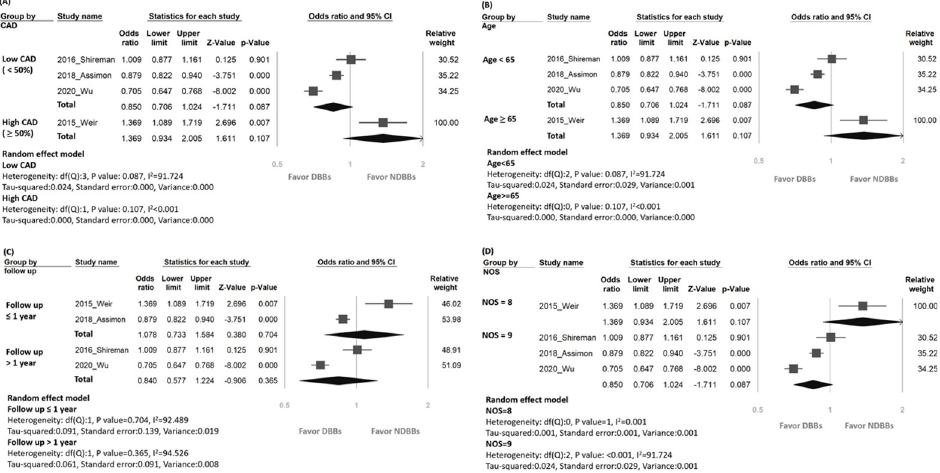
Fig 3. Forest plots of subgroup analysis of the effects of (A) low ( < 50%) vs. high ( � 50%) proportion of patients with coronary artery disease (CAD), (B) Age < 65 vs. � 65 years, (C) follow-up duration ≦ 1 vs. > 1 year, (D) Newcastle- Ottawa Scale Quality Assessment (NOS) score 8 vs. 9 on mortality risk of patients on dialysis receiving beta-blockers. DBBs, dialyzable beta-blockers; NDBBs, non-dialyzable beta-blockers; CI, confidence